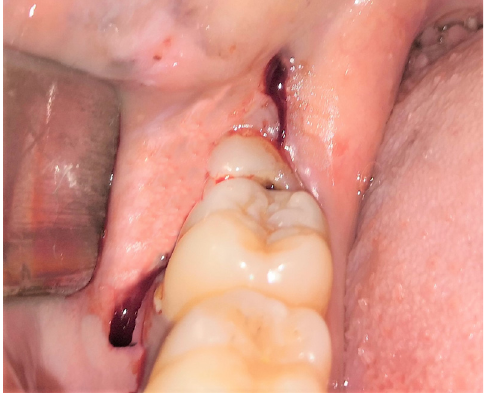
Fig. 1. Surgical incision for buccal based triangular fl ap.